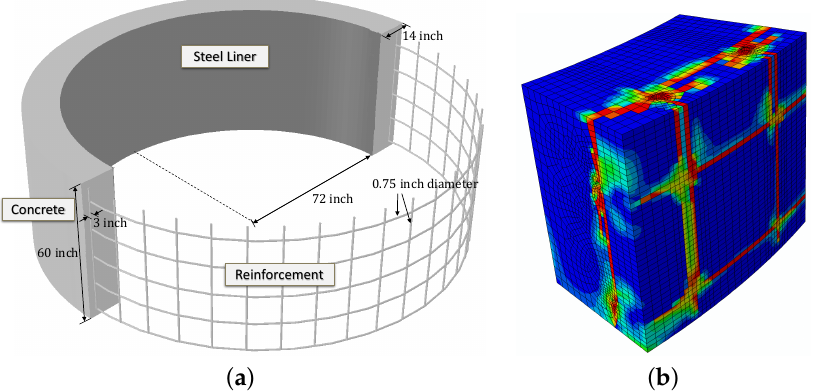
Figure 3. FEM of concrete ring structure [63]. ( a ) concrete ring structure; ( b ) degradation in